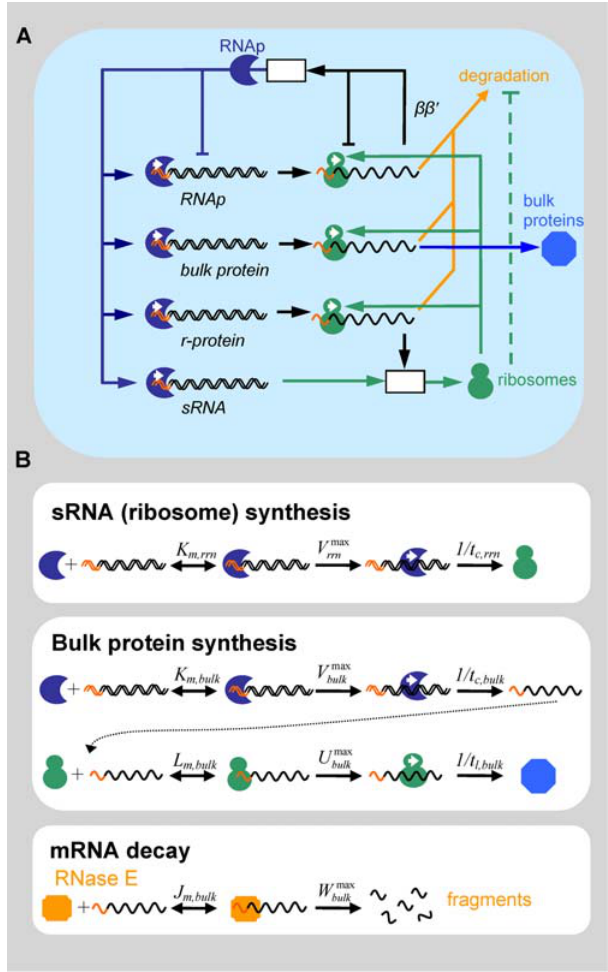
Figure 1. The coarse-grained genetic reactor (CGGR) model of E.coli . (A) A schematic diagram of the cell as a CGGR. This figure depicts the various gene classes (double stranded DNA on the left), mRNA (single stranded RNA on the right) and their expressed products, stable RNA and the various positive ( R ) and negative ( x ) feedbacks between these components. The colored tips on the DNA and mRNA represent the promoter binding sites and the ribosome binding sites (RBSs) respectively. The white boxes denote the process of assembly of functional complexes from immature subunits. The light blue back- ground represents the finite volume of the cell in which reactions take place, which is determined by the DNA replication initiation system (see text and S2.2 in Text S1). (B) The basic reactions taking place in the cell: K m , i , V max are the Michaelis-Menten (MM) parameters for transcription i initiation of gene class i [3,28], followed by transcription at a rate